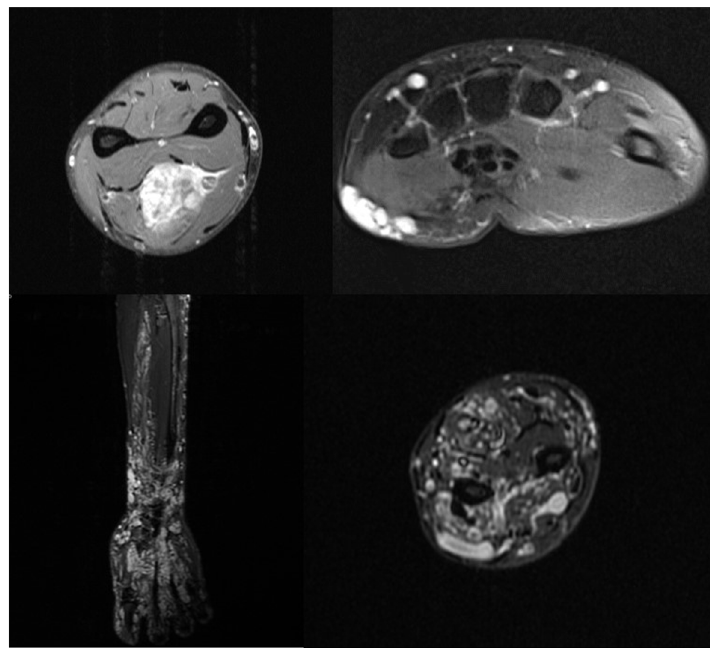
Fig. 6 Aspect of a well-defined (top) and diffuse (bottom) VM on